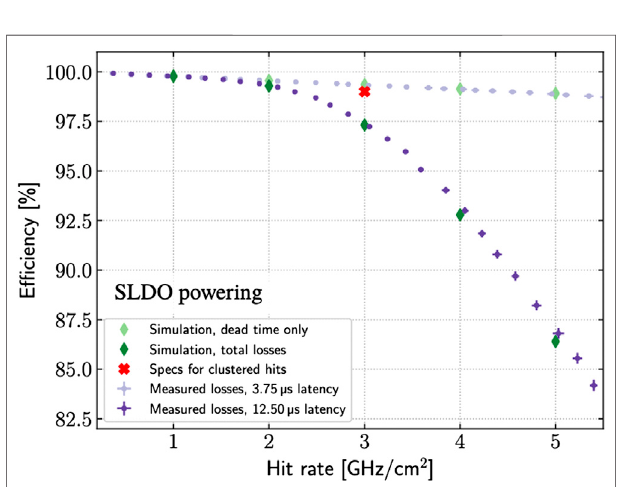
FIGURE 8 | Ef fi ciency vs hit rate fl ux generated by X-ray, that generate single hit clusters: data well fi t the simulation prediction. Simulation prediction for clustered hits coming from particles are also shown, see text From